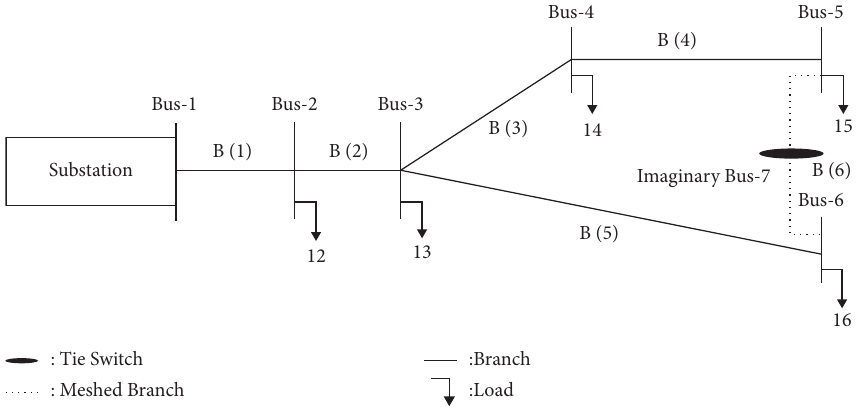
Figure 3: Six-bus balanced weakly meshed distribution